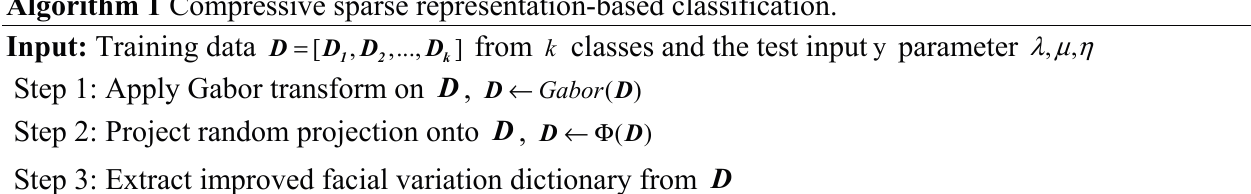
Algorithm 1 Compressive sparse representation-based